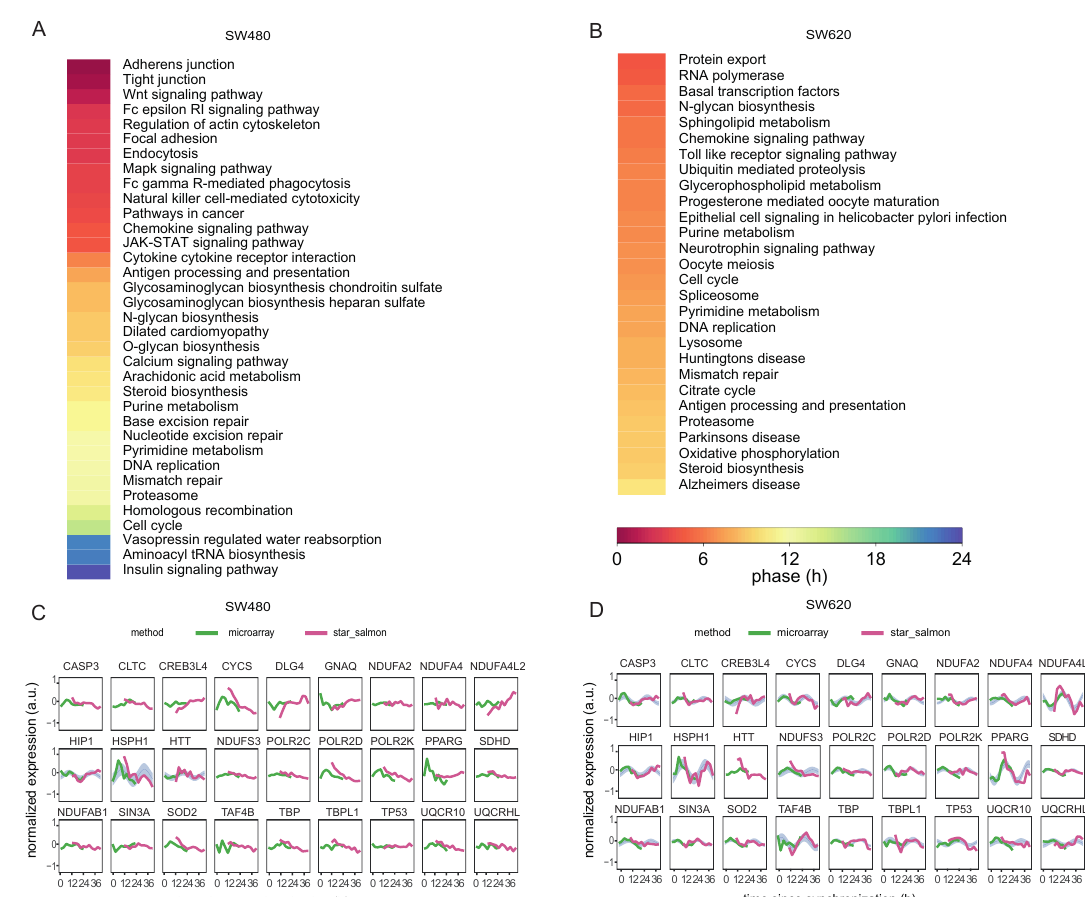
Figure 4. Phase-clustered circadian pathways in SW480 and SW620 cells. Circadian-phase-clustered KEGG pathways enriched for 24 h rhythmic gene sets identified for SW480 cells ( A ) and SW620 cells ( B ). The colors represent the vector-average phases of the pathways. Normalized time series expression of the HD associated genes (27 genes) in SW480 cells ( C ) and SW620 cells ( D ) based on the concatenated data. Microarray expression values are represented by green lines and RNA-seq expression values by pink lines. The blue area marks the confidence area of the harmonic regression fitted to the concatenated data for 24 h rhythmic